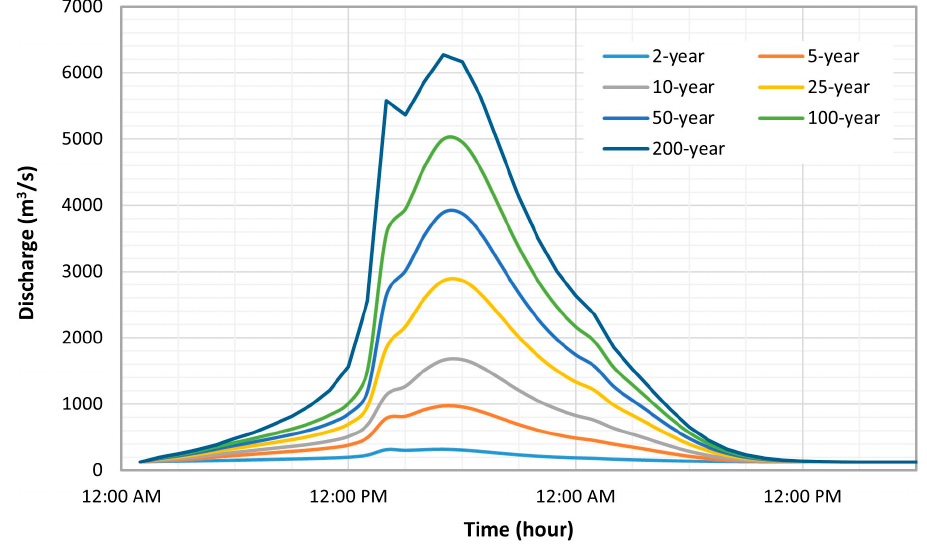
Figure 8. Reservoir flood inflow hydrographs for different return periods of the designed